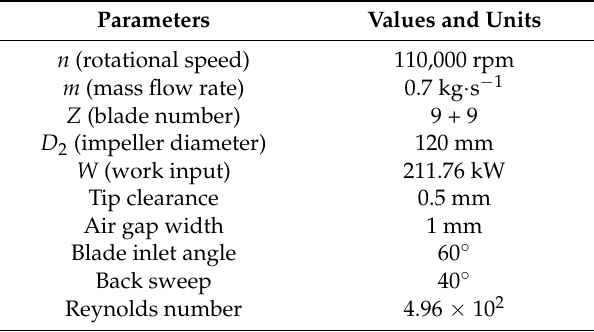
Table 1. Compressor parameters. Table 1 . Compressor parameters.